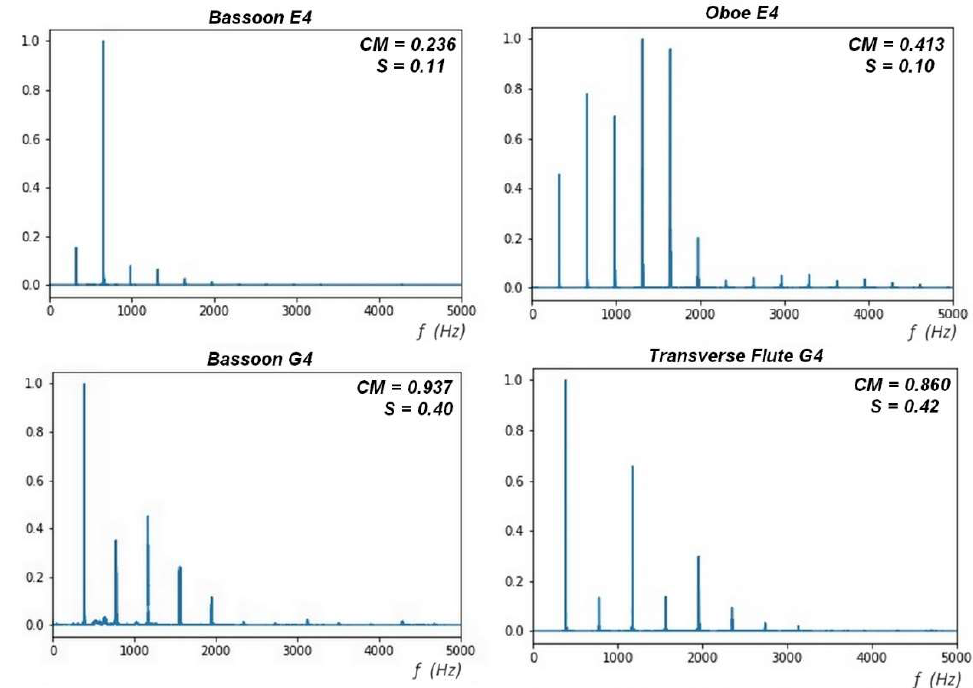
Figure 13. Average contrast in the FFT spectra of the audio records. Top panel: E4 sound for Bassoon ( CM = 0.236) and Oboe ( CM = 0.413), both with similar brilliance ( S ≈ 0.1). Bottom panel: G4 sound for Bassoon and Flute both with similar medium contrast ( CM ≈ 0.9) and brightness ( S ≈ 0.4).